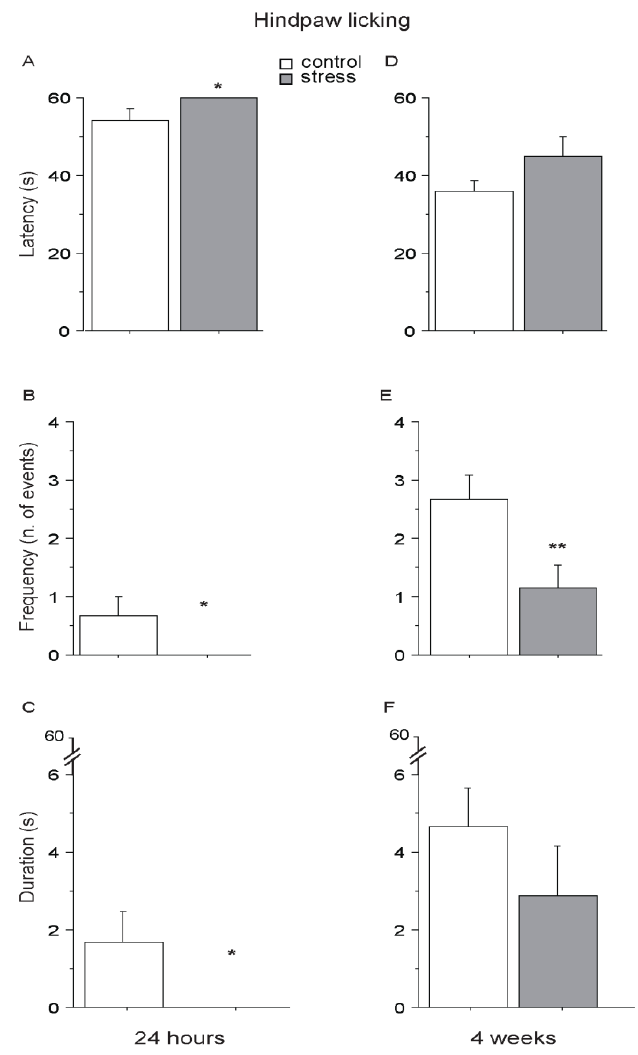
Figure 5. Hot Plate (HP) Test. Twenty-four h after the end of stress, SD mice were characterized by an increase in pain threshold (SIA) showing a higher latency ( A ) and a reduced frequency ( B ) and duration ( C ) to perform hindpaw licking . A SIA profile was still apparent 4 weeks after the end of the stress procedure, when SD mice performed hindpaw licking with a lower frequency than CTRLs ( E ). No effect was observed as for the latency ( D ) and duration ( F ). Data are presented as mean +S.E.M. n = 7 (SD) and 6 (CTRL). * p < 0.05. ** p < 0.01. Subjects were tested only once either at 24 h or after 4 weeks after the end of